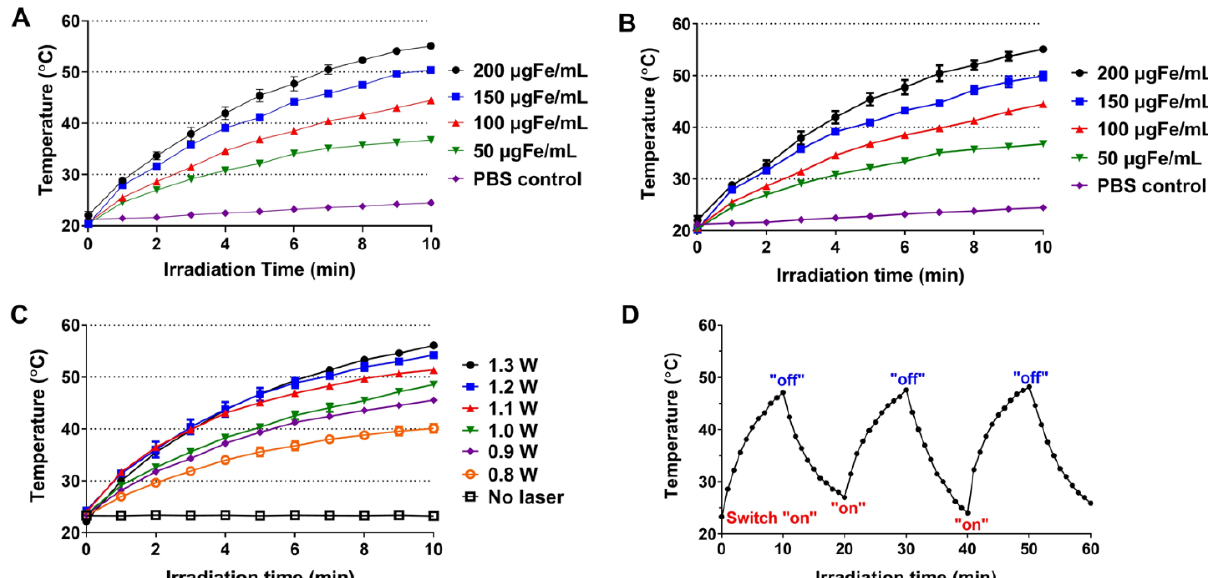
Figure 6. In vitro assessment of the photothermal activity of starch–IONPs and PEG–starch–IONPs. Temperature profiles of particle suspension after laser irradiation with fixed laser power (1.3 W) at varying concentrations (0–200 μ g Fe/mL) of ( A ) starch–IONPs or ( B ) PEG–starch–IONPs. Temperature profiles of PEG–starch–IONP suspension irradiated laser ( C ) at a given PEG–starch–IONP concentration (200 μ g Fe/mL) with different laser powers (0.8–1.3 W), and ( D ) by a switch “on and off” mode at 1 W with PEG–starch–IONP suspension concentration of 100 μ g Fe/mL.